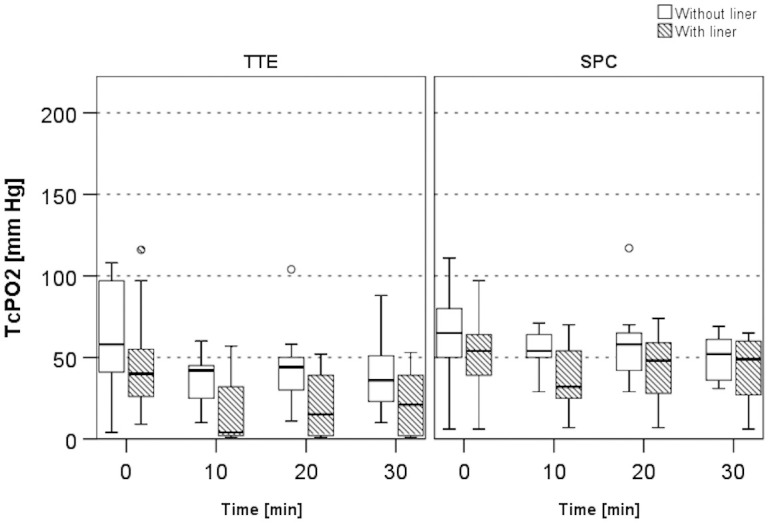
TcPO2 levels for Sensors TTE and SPC.Median TcPO2 levels with and without liner wear for time points T0, T10, T20, and T30 minutes. Median, inter-quartile range and total range (and outliers if applicable) are shown.